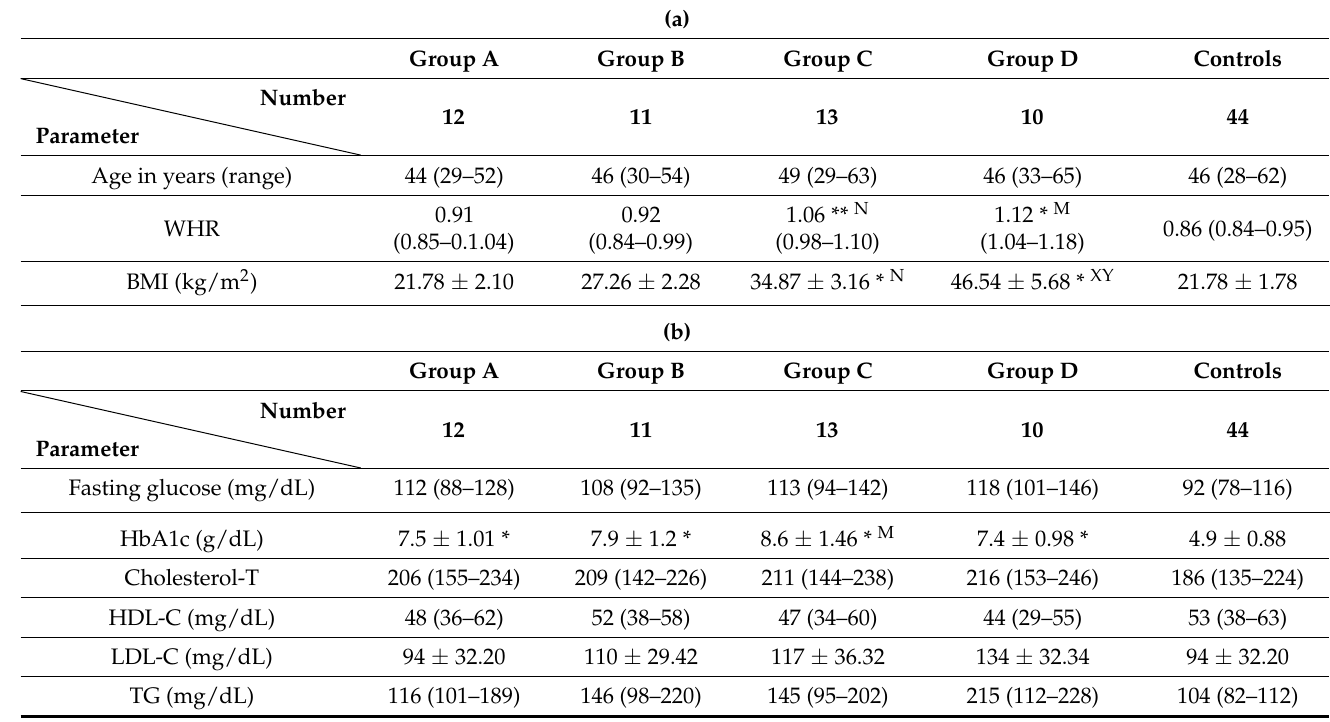
Table 1. ( a ) Anthropometric indices of male T2DM patients and controls. ( b ) Biochemical parameters of male T2DM patients and